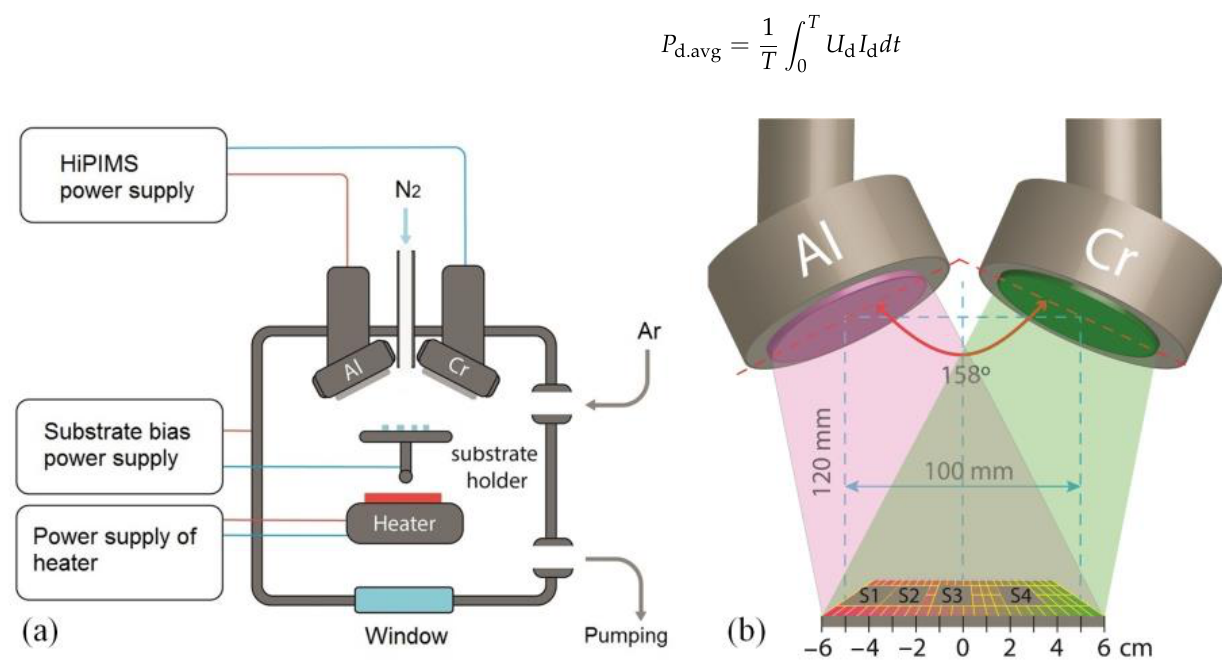
Figure 1. ( a ) Flow-chart of the proposed dual-HiPIMS vacuum system and ( b ) arrangement of S1–S4 substrates on the holder relative to magnetrons.